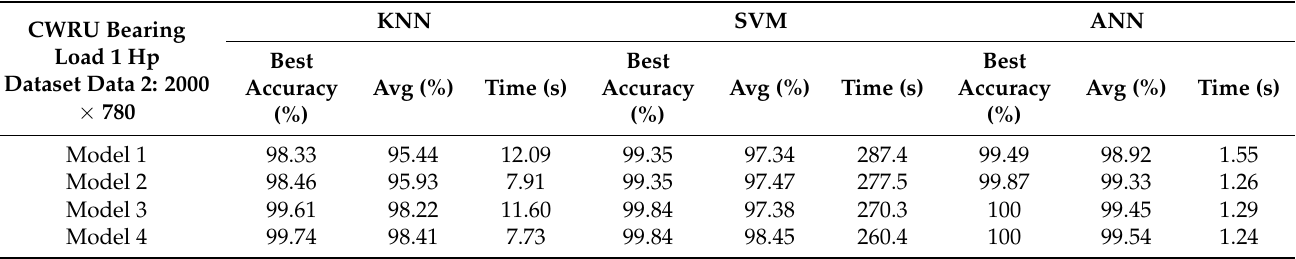
Table 7. Result in CWRU bearing load 1 Hp dataset.